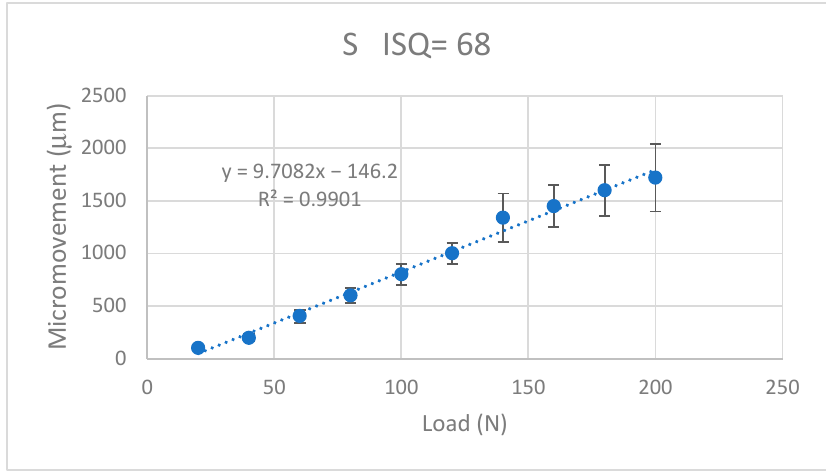
Figure 10. Micromovements in micrometers associated with the load in N for the S implants.